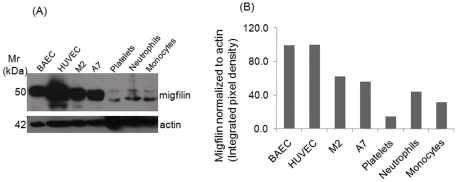
Migfilin expression in different human vascular cells.(A) Immunoblots showing migfilin in whole cell lysates of different circulating and non-circulating cell types. Migfilin immunoblots reflect signals after 5 min of exposure while the actin bands were exposed for ∼2 seconds on the X-ray film. (B) The intensities of the 50 kDa migfilin band were quantified by densitometry and normalized to actin band intensities in the same gels.